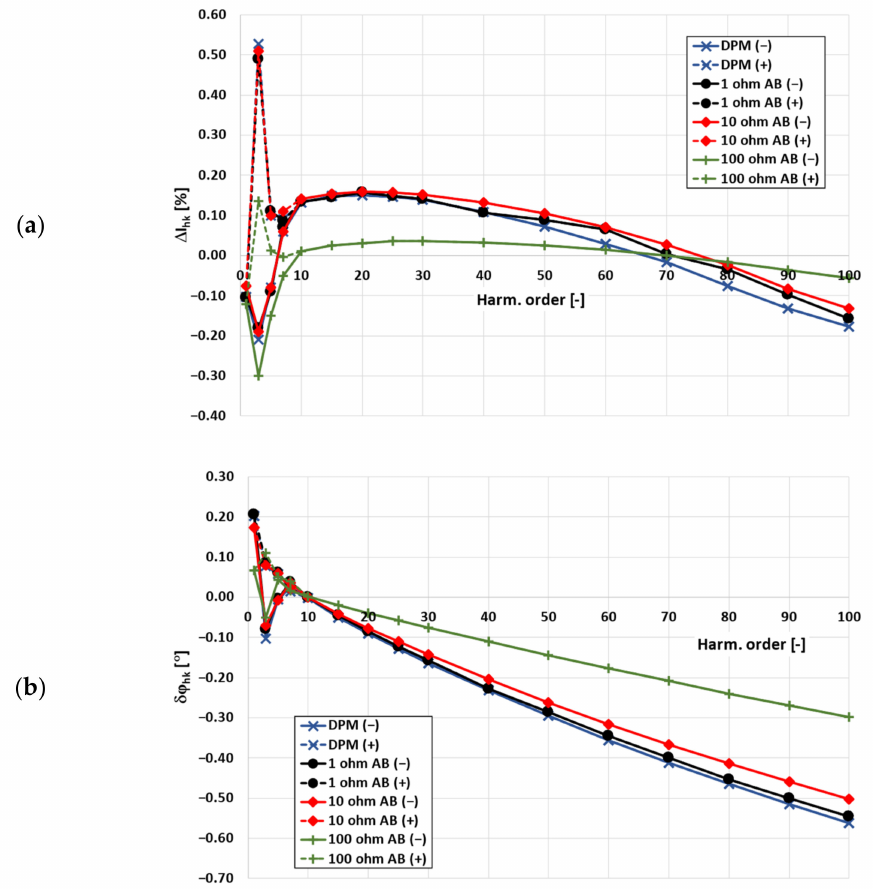
Figure 6. The influence of the self-generated low-order higher harmonics by the 50 Hz-type CT and current shunt resistance on current error ( a ), phase displacement ( b ) for rated primary current and load resistance (used notations are as in Figure